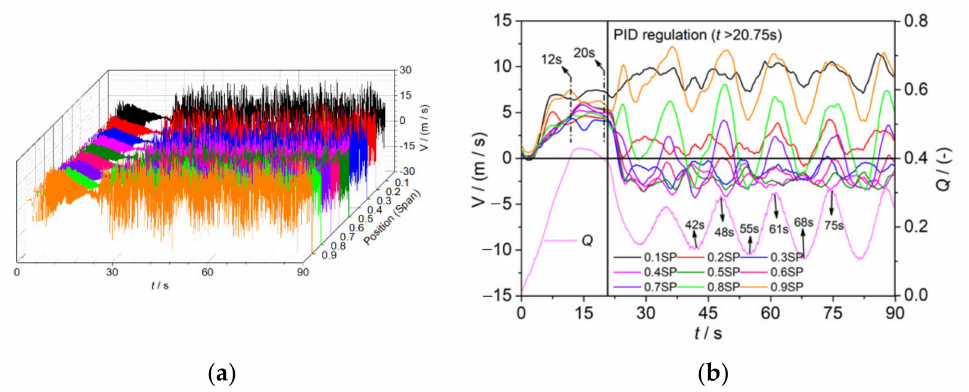
Figure 11. Backflow features at the runner inlet during start-up in Case2. ( a ) Original data; ( b ) The low-pass filtered data.